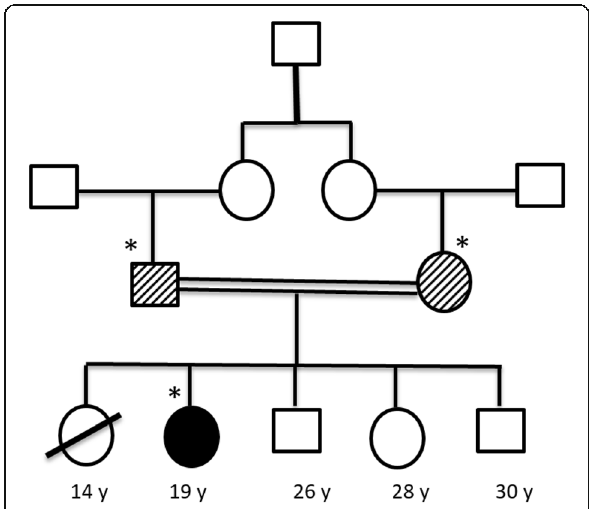
Fig. 1 The patient ’ s pedigree chart. *Mutation screening was done for the patient and her